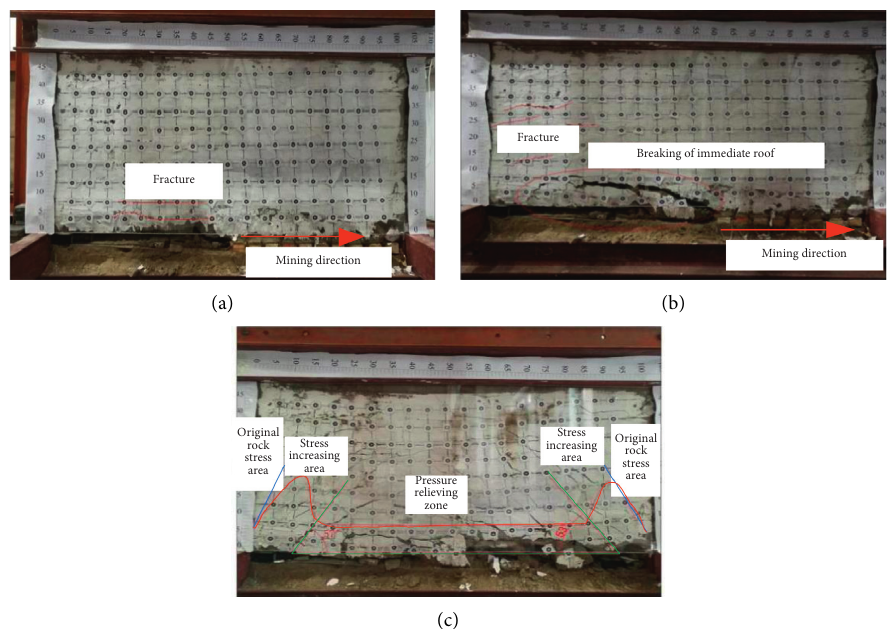
Figure 7: Excavation along the dip of the coal seam. Coal seam excavation: (a) 20m; (b) 45m; (c) 80m.